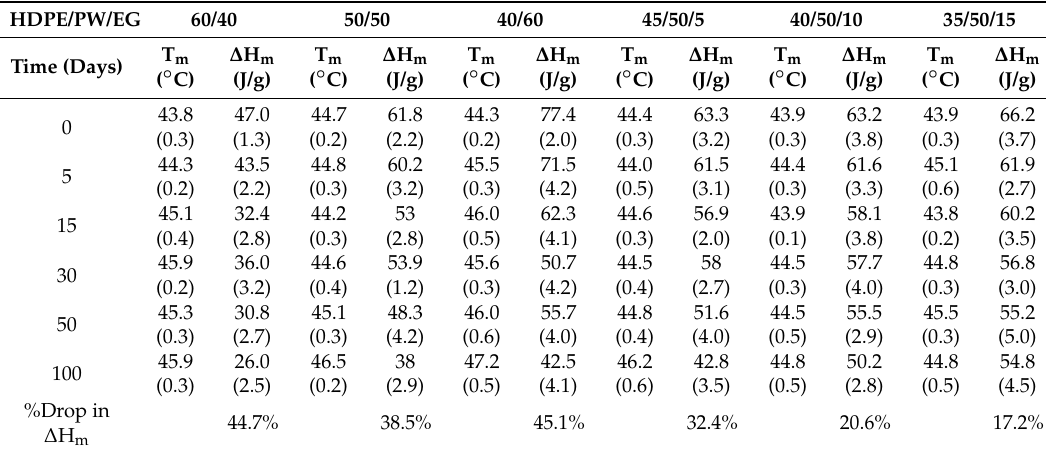
Table 1. DSC melting temperatures and enthalpies for the different compositions of PCMs during aging.